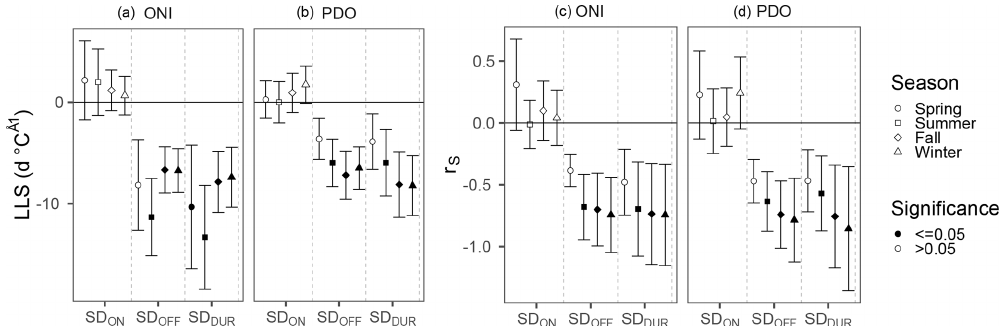
Figure 9. Summary of the linear least squares (LLS; a, b ) and Spearman correlation coefficients ( r S ; c, d ) for each of the three measurements (SD ON SD OFF , and SD DUR ) by teleconnection (ONI and PDO) and season. The y axis shows the rate of change in days per degree Celsius teleconnection anomaly (d ◦ C − 1 ) and the Spearman correlation coefficient ( r S ). The point fill denotes insignificant relationships ( p > 0 . 05) as white and significant ones ( p ≤ 0 . 05) as black. Error bars represent the 25th and 75th percentiles of the 10000 iterations during which the snow measurements are adjusted using a random sample of the difference between the MODIS data and the ASWS data. See the Supplement for all plotted